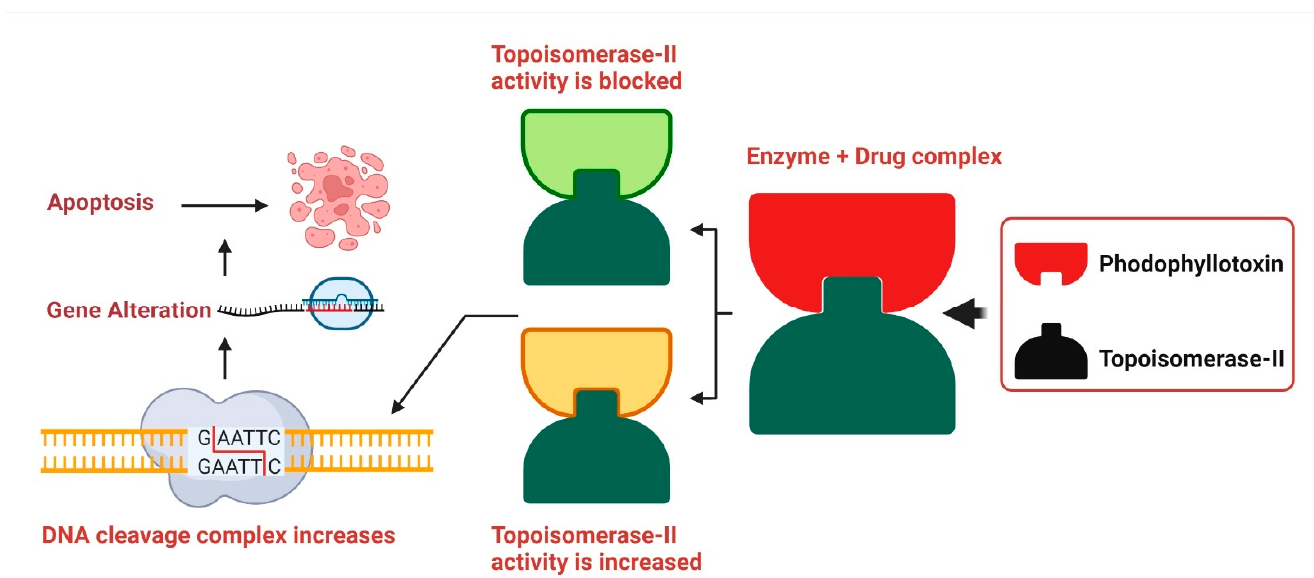
Figure 4. Podophyllotoxin’s Mode of Action. The DNA replication inhibitors etoposide and tenipo- side interact with topoisomerase II, and podophyllotoxin is a suitable replacement for them. DNA cleavage is accelerated by this bioactive compound because it stimulates the production of topoiso- merase II. Though it does not block topoisomerase II’s catalytic activity, etoposide is toxic to the enzyme, resulting to increased DNA duplex cleavage and irreparable double-stranded DNA breaking. However, genetic rearrangements such recombination, translocation, deletion, and insertion lead to cell death. Originally published by Kumar et al.